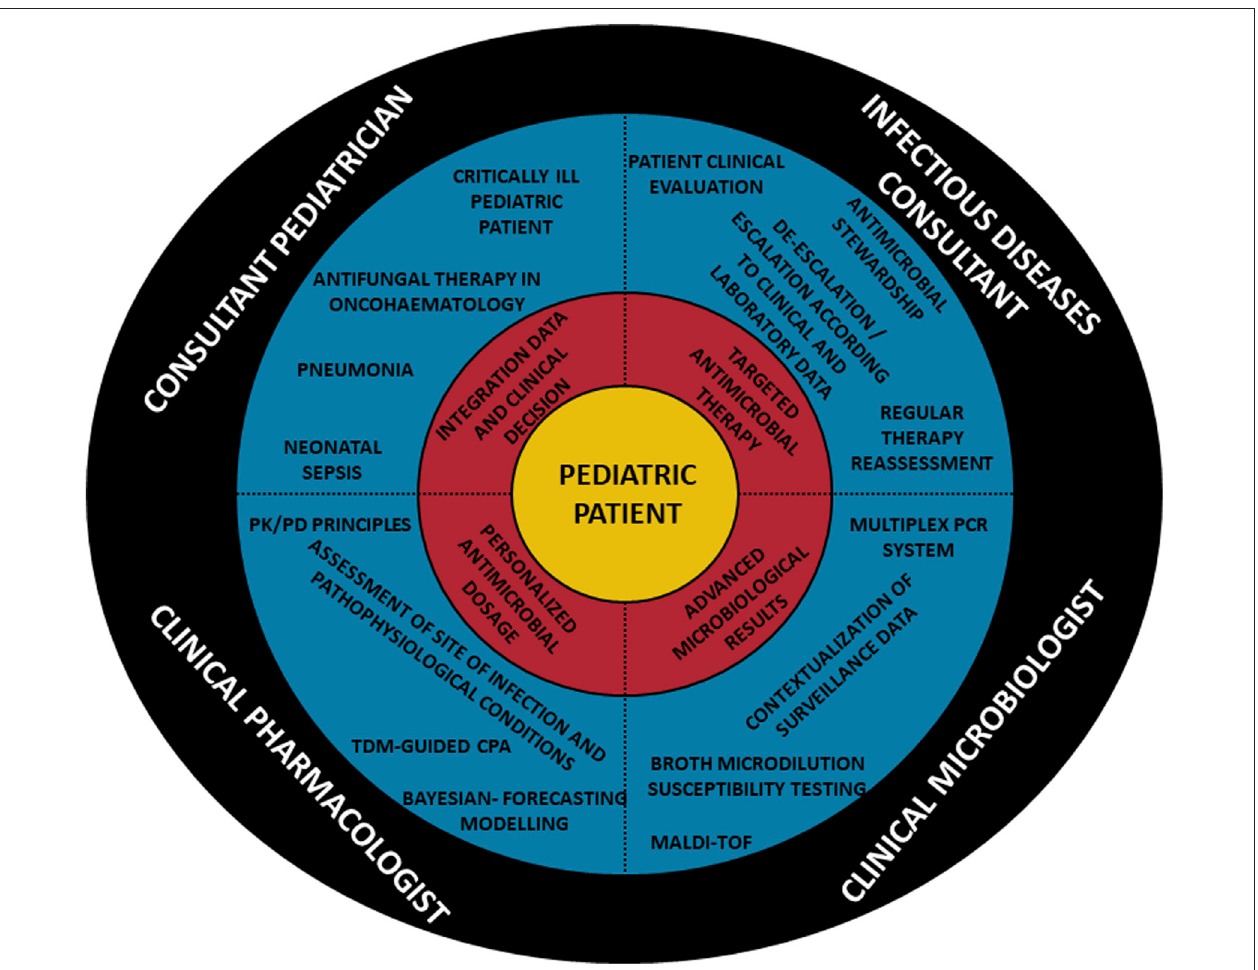
FIGURE 2 | Features of multidisciplinary taskforce involved in the management of empirical and targeted antimicrobial therapy in paediatric patients. CPA, clinical pharmacological advice; MALDI-TOF, Matrix Assisted Laser Desorption Ionization – Time of Flight; PK/PD, pharmacokinetic/pharmacodynamic; TDM, therapeutic drug